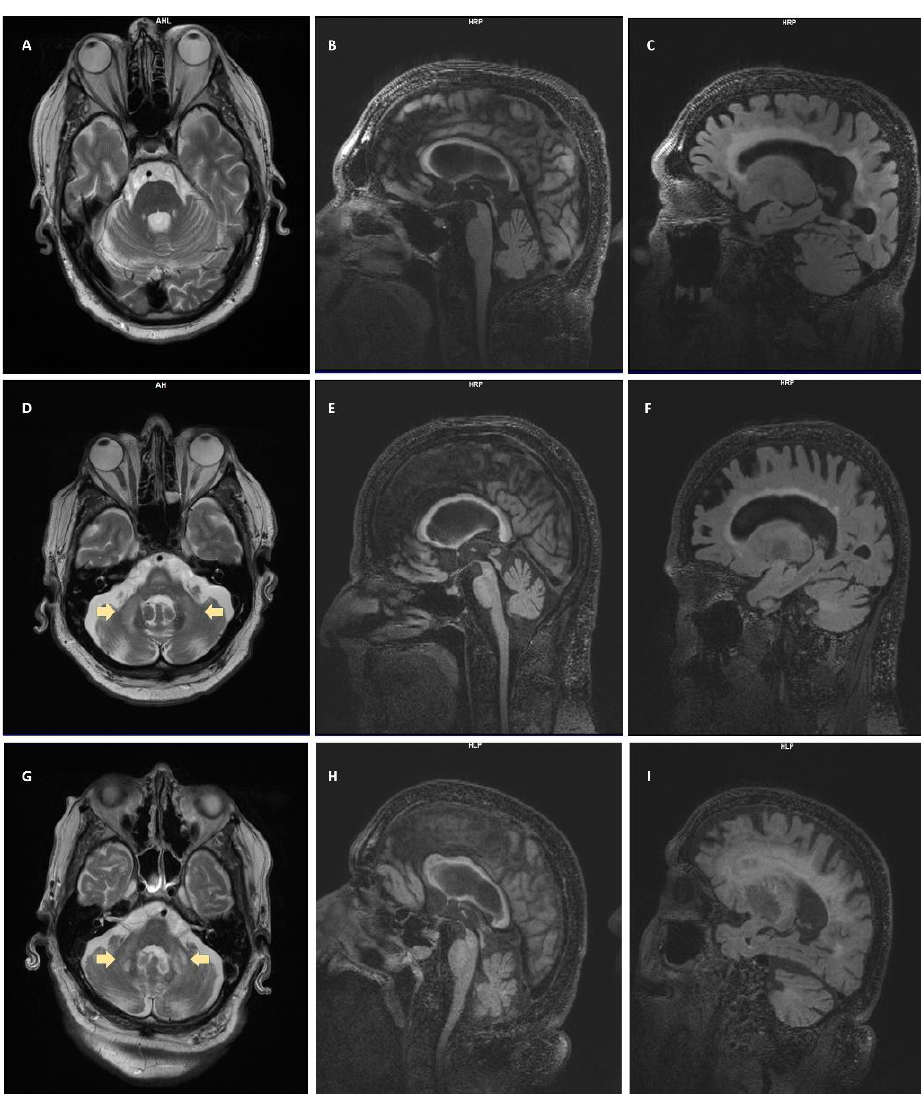
Figure 1. Radiological Evaluation. Case 1 ( A ) T2- weighted turbo spin echo (T2-TSE) no middle cerebellar peduncle (MCP) sign; ( B ) T2-weighted-Fluid-Attenuated Inversion Recovery (T2-FLAIR) splenium and genu signs; ( C ) T2-FLAIR general atrophy, ventriculomegaly. Case 2 ( D ) T2-TSE MCP sign (arrows); ( E ) T2-FLAIR splenium and genu signs; ( F ) T2-FLAIR general atrophy, ventriculomegaly, periventricular white matter disease (WMD). Case 3 ( G ) T2-TSE MCP sign (arrows); ( H ) T2-FLAIR splenium and genu signs; ( I ) T2-FLAIR general atrophy, ventriculomegaly, periventricular WMD. On cognitive testing using the WAIS IV, full-scale IQ was 107. BDS-2 was 20 out of 27, suggesting some executive function deficits, whereas MMSE was 29 out of 30. Upon completion of the medical evaluation, he met criteria for probable stage III FXTAS and he also met criteria on the SCID-5 for minor depression (see Table 2 for additional